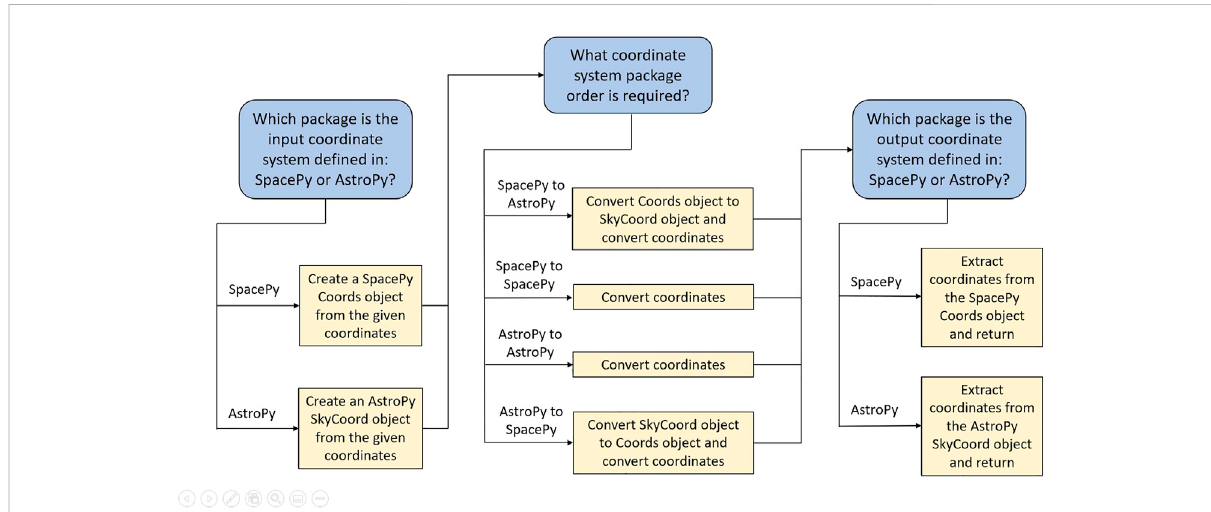
FIGURE 2 Concept map for the ConvertCoords function. Blueboxes indicate conditional arguments,yellowboxes show tasks executed depending upon the evaluation result of the preceding conditional argument. Error catching logic is not included in the fi gure for simplicity. The inputs to the argumentincludeonedimensionalarraysofthetimeandspatialcoordinates(41Darrays),andfourstringsindicatingtheinputandoutputcoordinate systemsandwhethereachisCartesianorspherical.Thevaluesreturnedareonedimensionalarraysofthespatialcoordinates(31Darrays)anda list of strings containing the units of the output coordinates. Model-speci fi c coordinates are handled external to this